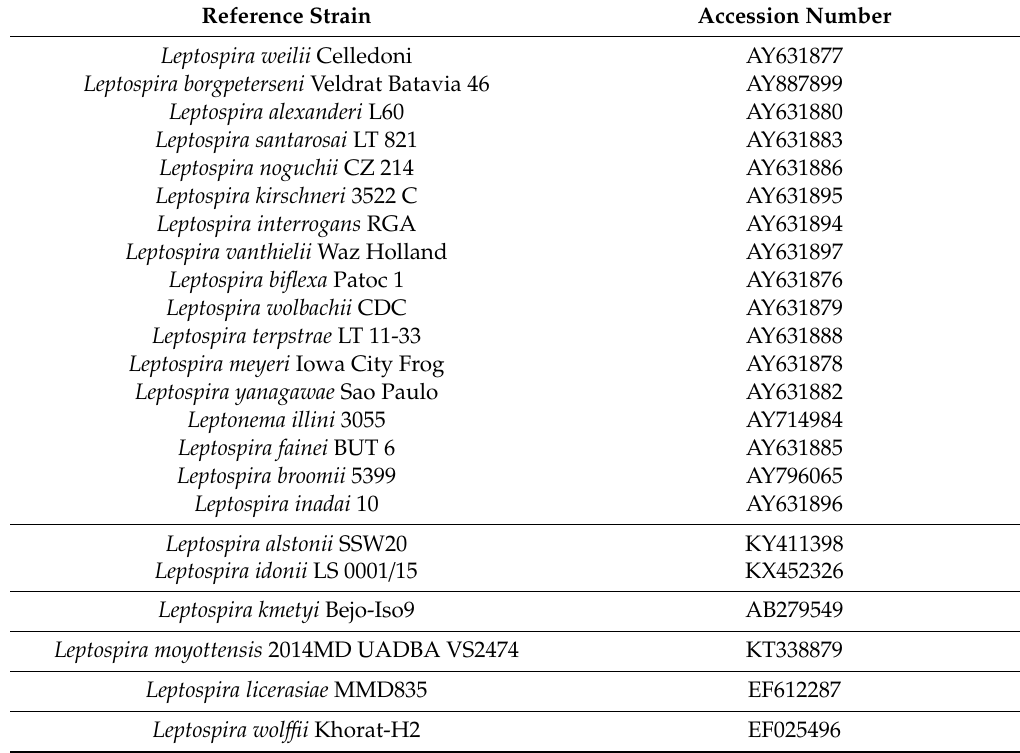
Table 1. Strains studied and their 16S rRNA gene Genbank accession